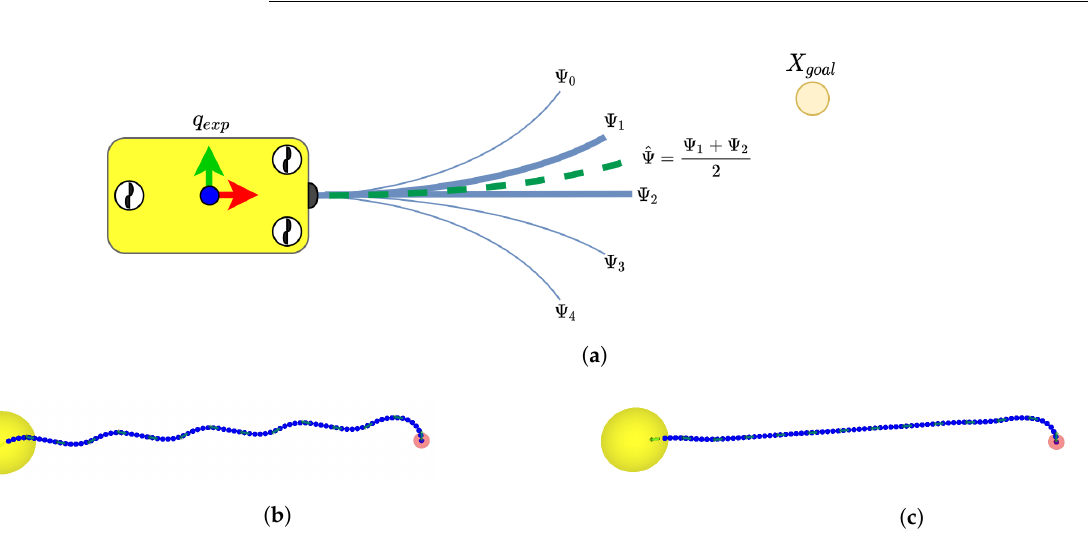
Figure 3. ( a ) When a state is expanding it applies a binary search to find a motion primitive which leads to the state that is closest to the goal within the set of motion primitive’s outer limits. This state should, if within the current capabilities from q exp , have a heading towards the goal configuration. ( b ) A path found without using binary search. ( c ) Using binary search can create a path that is heading towards the goal in a straighter path, and therefore also resulting in a shorter path